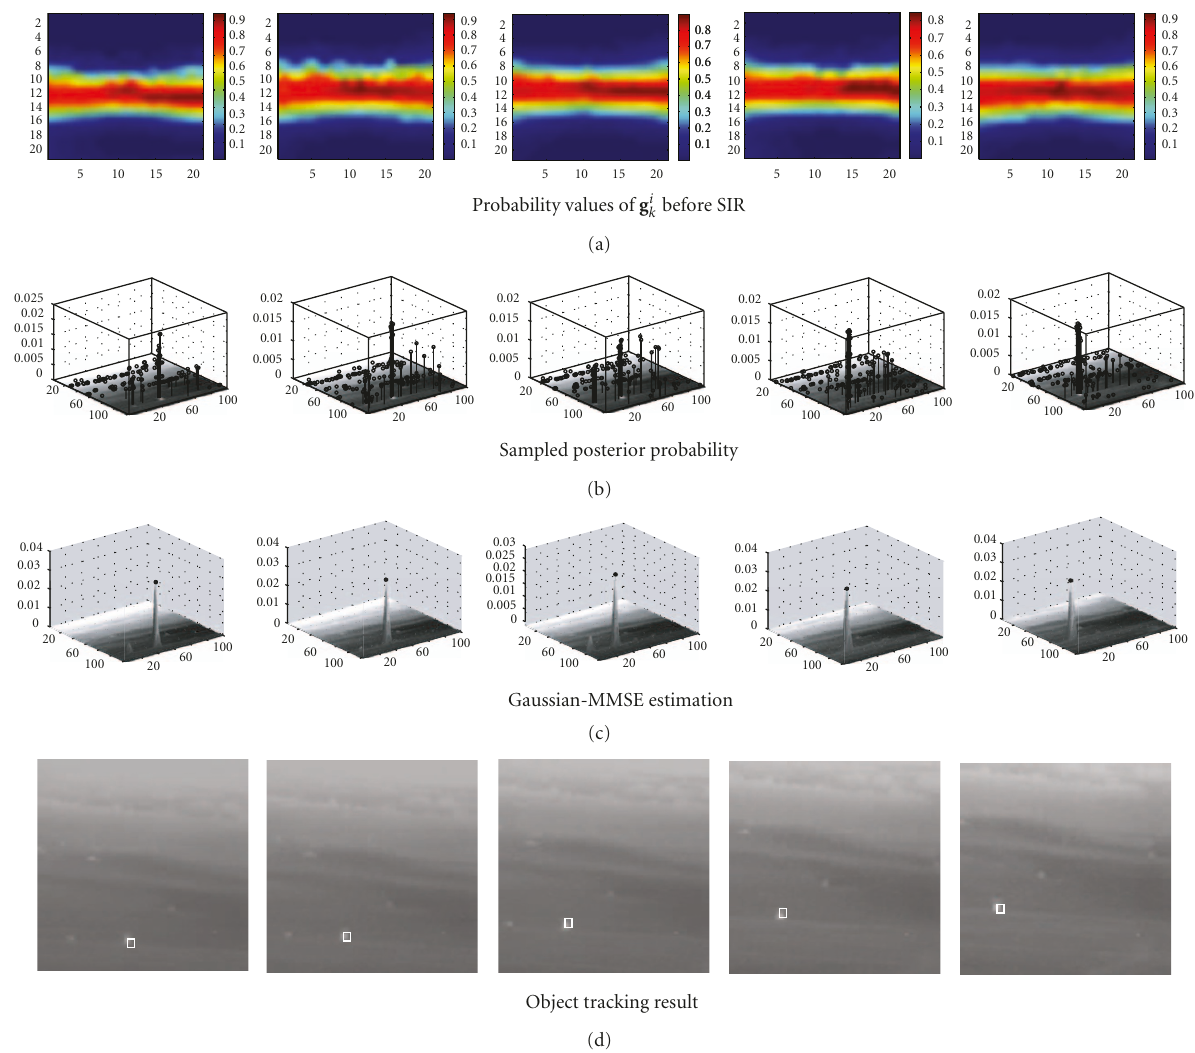
Figure 16: Tracking results for the BEH algorithm in a situation where the ego-motion compensation is especially challenging due to the aperture